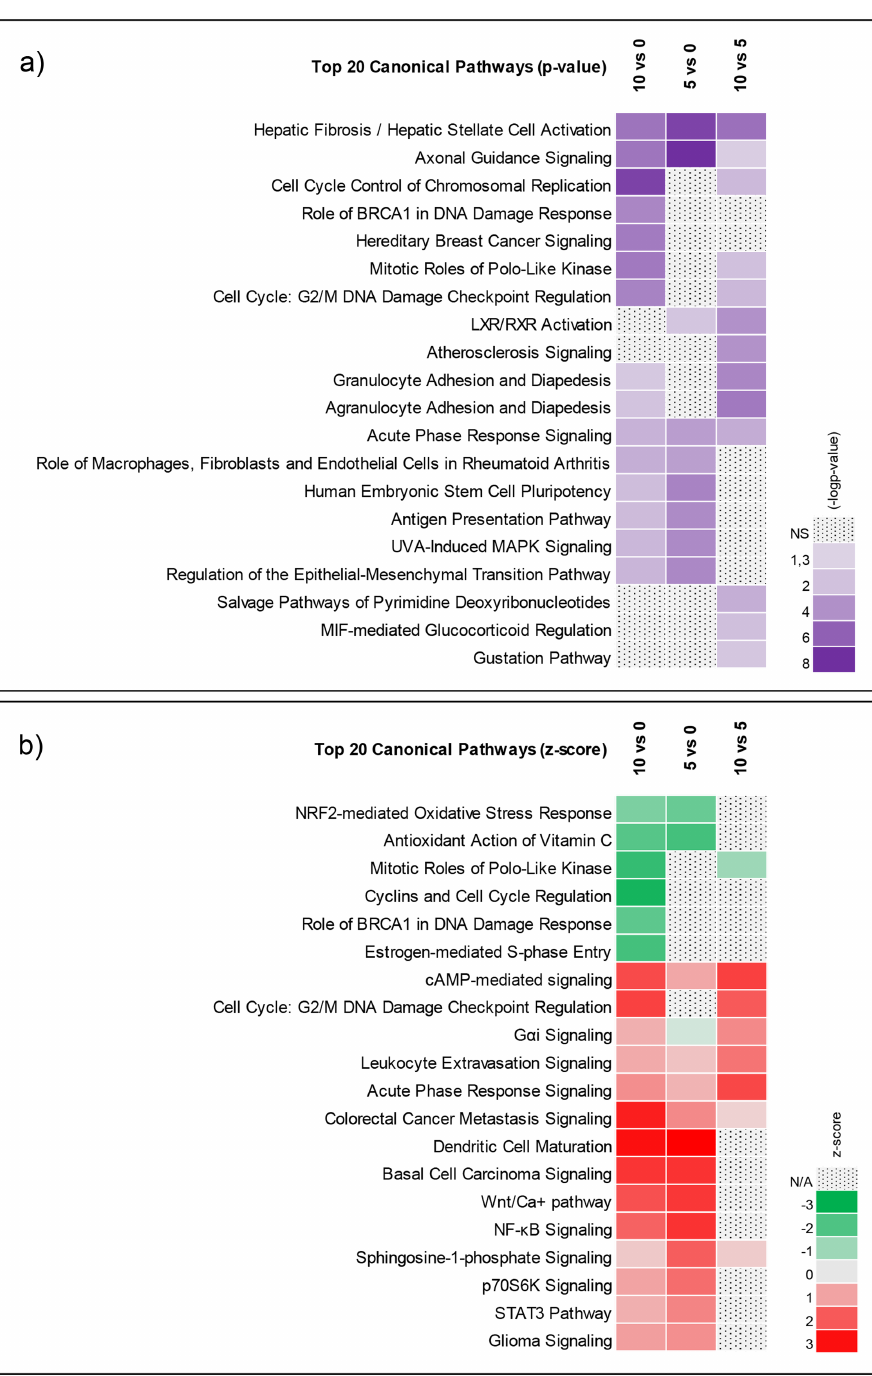
Fig 3. Canonical pathway analysis of differentially expressedgenes using IPA. a) Top 20 Canonical pathways as per p-value b) Top 20 as per z-score (a measureof the predicteddirectionof the pathway